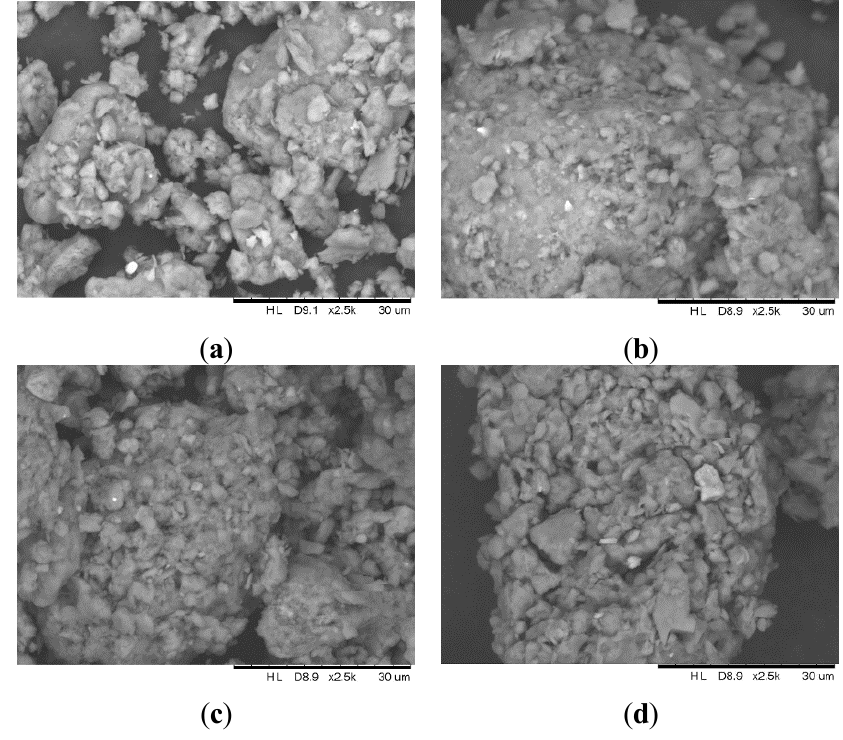
Figure 2. Scanning Electron Micrographs of the adsorbents: NC ( a ); HC ( b ); BC ( c ) and TC ( d